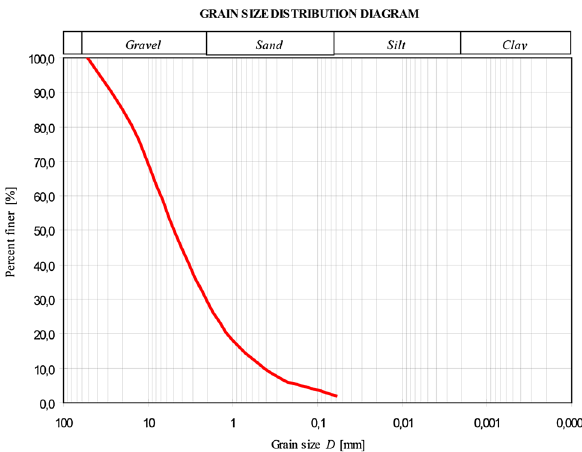
Fig. 6 Experimental setup.